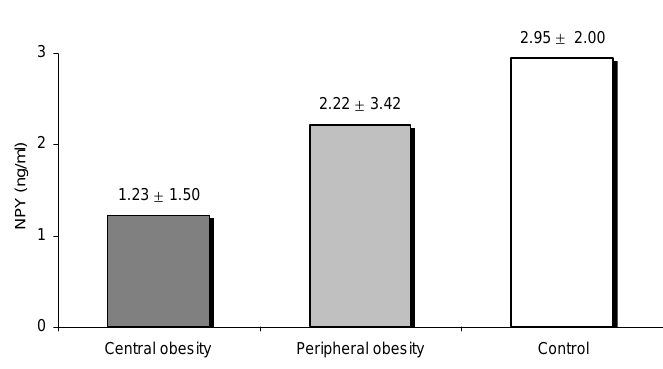
FIGURE 2 . NPY levels in different obesity types and control (mean ± SD).